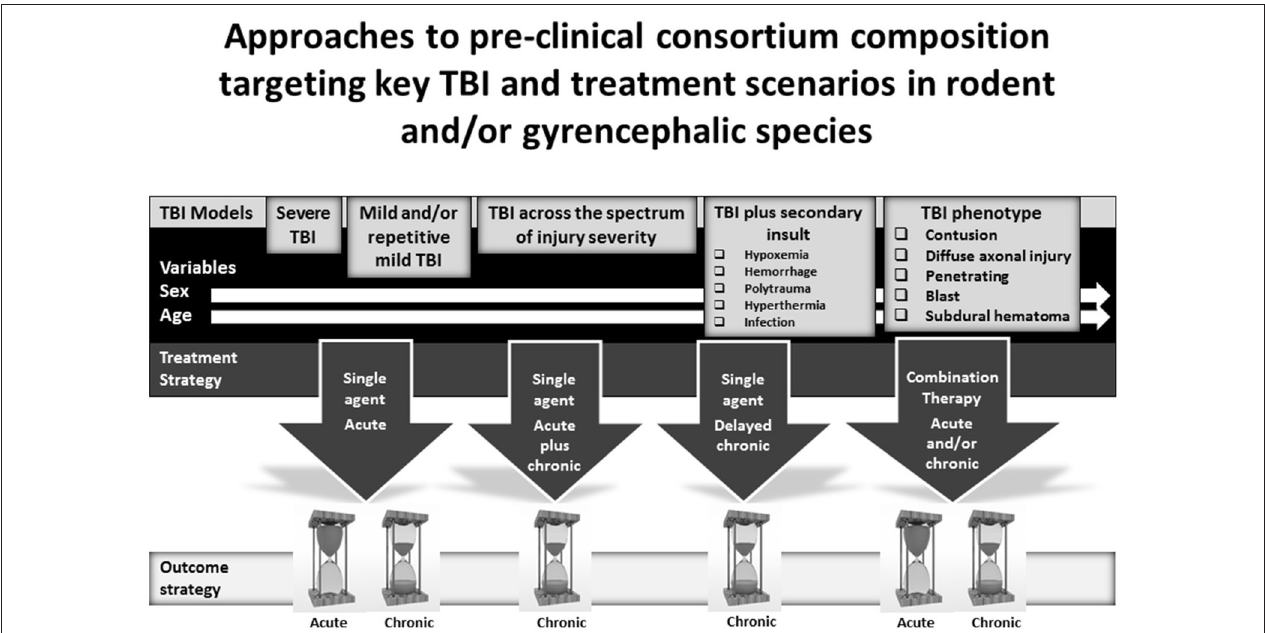
FIGURE 2 | Potential compositions of pre-clinical consortia for screening therapies for the treatment of traumatic brain injury (TBI) including (1) models targeting mild or severe TBI, secondary insults, and TBI phenotypes, (2) treatment strategies, and (3) evaluation of early or long-term outcomes.